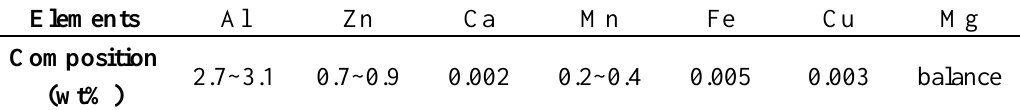
Table 1. Chemical composition of AZ31B Mg alloy sheets